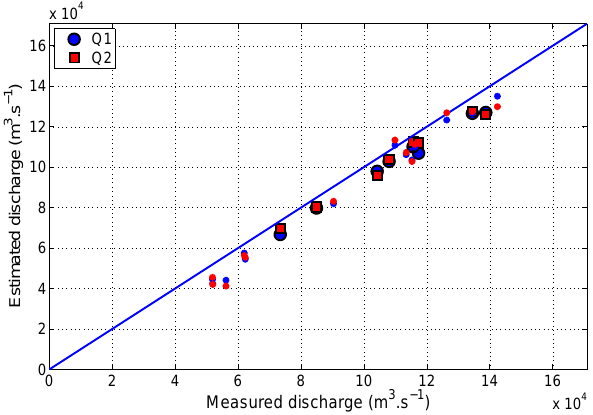
Fig. 1. Comparison of the estimated discharge using Eqs. (8) and (9) and the ADCP discharge measurements at Manacapuru gauging station. The calibration points are plotted with blue and red stars for Q 1 and Q 2